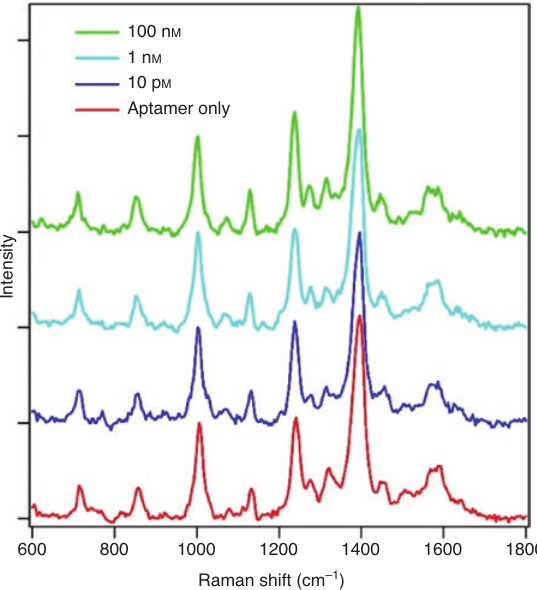
Figure 2: Normalized SERS spectra obtained from (red) only the aptamer, and the aptamer with (blue) 10 pm, (light blue) 1 nm, (green) 100 nm MnSOD. the same substrate. A 660 nm CW laser (0.4 mW) was used for